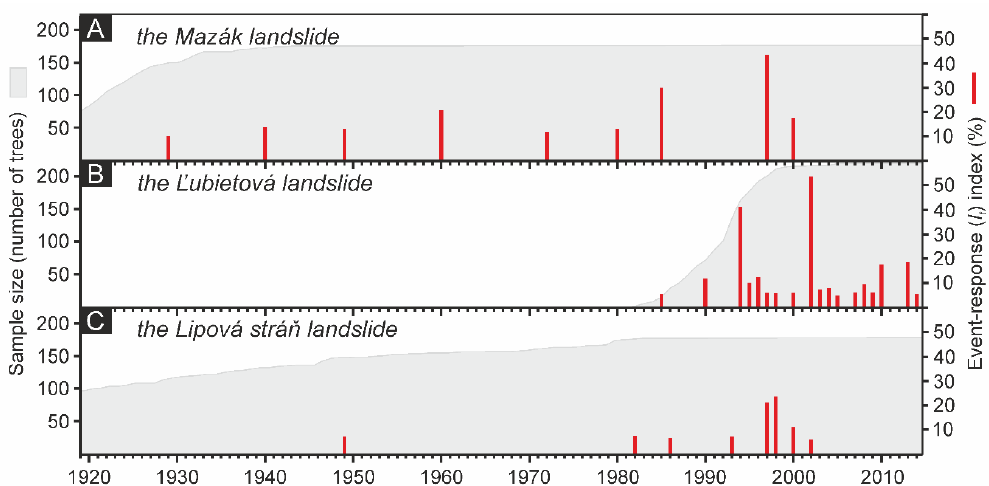
Figure 2. The chronology of dated mass movement events from all studied landslides expressed in terms of the standard event-response ( I t ) index ( A – chronology of the Mazák landslide, B – chronology of the Ľubietová landslide, C – chronology of the Lipová stráň landslide).